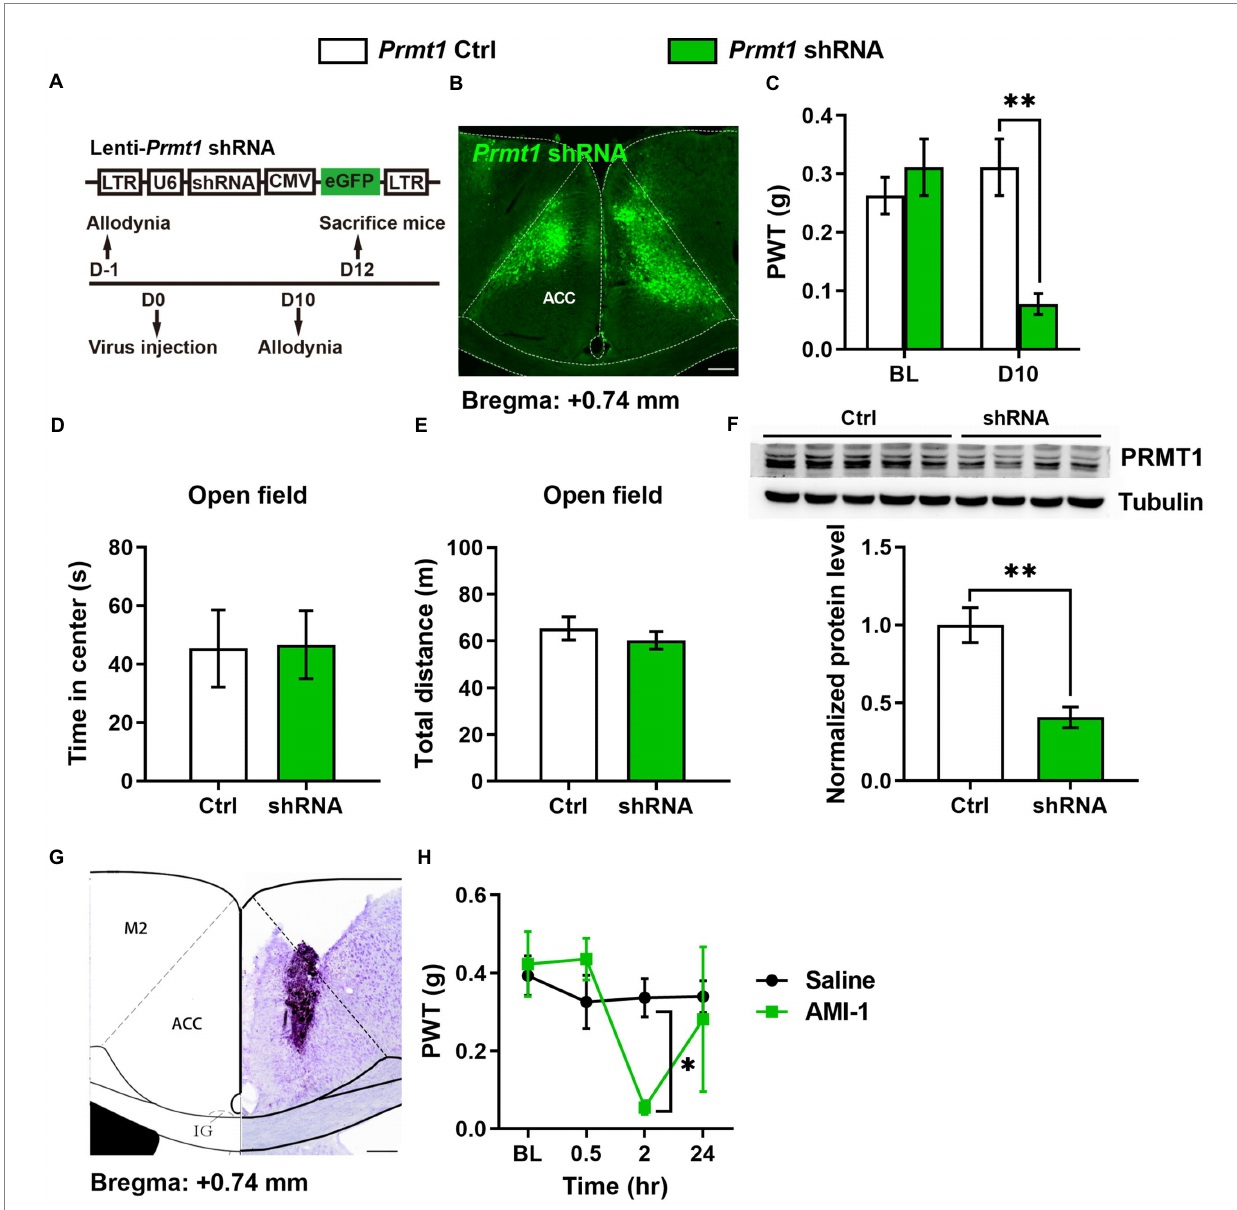
FIGURE 2 Downregulation of cingulate PRMT1 was sufficient and necessary for the development of peripheral hypersensitivity (A) Up: schematics of lentivirus vector engineered shRNA to knock down Prmt1 and eGFP control (Ctrl). Bottom: the experimental paradigm for behavioral testing. scale bar, 200 μm. (B) Illustration of bilateral expression of lenti- Prmt1 in C57BL/6 J mouse ACC. (C) PWT tests after Prmt1 shRNA expressed in the ACC (two-way RM ANOVA, interaction: F (2;36) = 23.95, p < 0.01, Time: F (2;36) = 16.95, p < 0.01, Ctrl vs. shRNA: F (1;36) = 152.63, p < 0.01, Ctrl: n = 10, shRNA: n = 10; “**” indicates p < 0.01; BL: baseline). (D) Statistics for the center time in the open-field test (Ctrl: n = 5, shRNA: n = 4, unpaired t -test, p > 0.05). (E) Statistics for the total distance in the open-field test (Ctrl: n = 5, shRNA: n = 4, unpaired t -test, p > 0.05). (F) Western blots and quantification showing efficient knockdown of PRMT1 by shRNA in the ACC (Ctrl: n = 5, shRNA: n = 4, unpaired t- test, p = 0.0039; “**” indicates p < 0.01). (G) Example injection site of cannula in the ACC of C57BL/6 J mice. (H) PWT tests after micro infusion of PRMT1 inhibitor, AMI-1, into ACC (Two-way RM ANOVA, interaction: F (1;9) = 10.19, p < 0.05, Time: F (1;9) = 13.51, p < 0.05, saline vs. AMI-1: (F) (1;9) = 7.24, p < 0.05, Ctrl: n = 6, AMI-1: n = 5; “*” indicates p < 0.05). Data are represented as mean ± SEM; ns, not